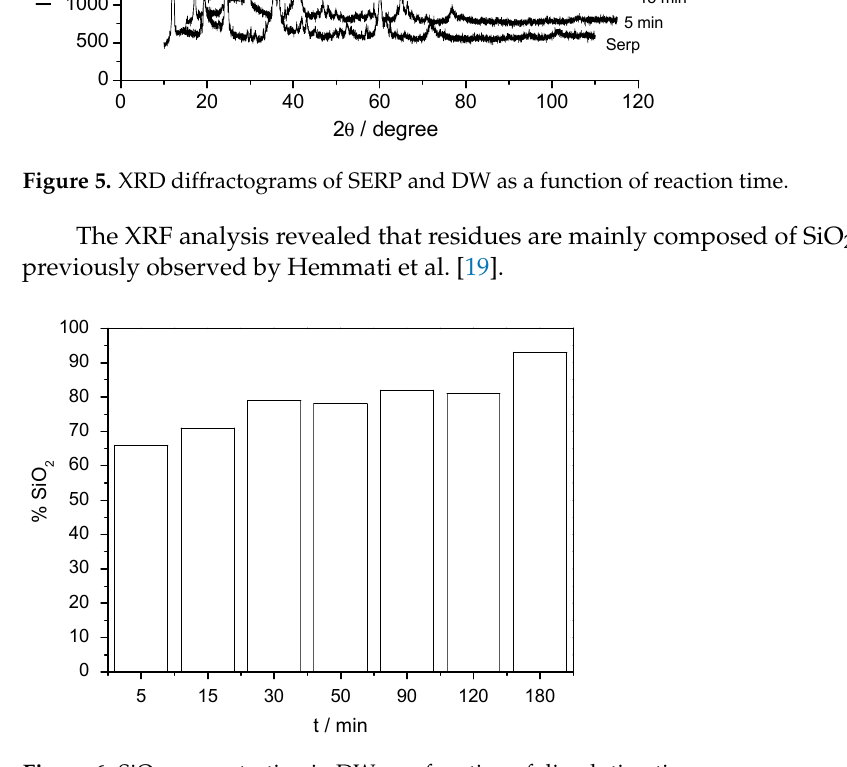
Figure 5. XRD diffractograms of SERP and DW as a function of reaction time.